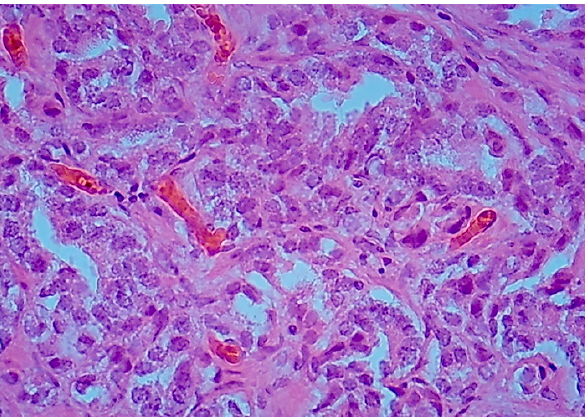
Fig. 4. The signet ring cells are positive for alcian blue stain (400 ×